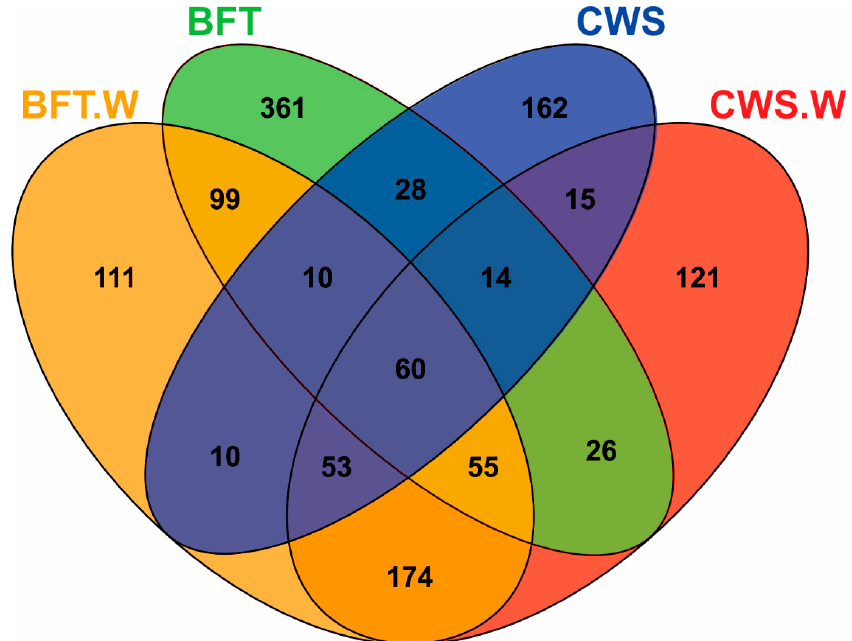
Figure 3. Venn diagram showing unique and shared operational taxonomic units (OTUs) of midgut bacteria of Litopenaeus vannamei reared in biofloc (BFT) and clear seawater (CWS) and challenged by the WSSV (BFT.W and CWS.W), by using a per os method.